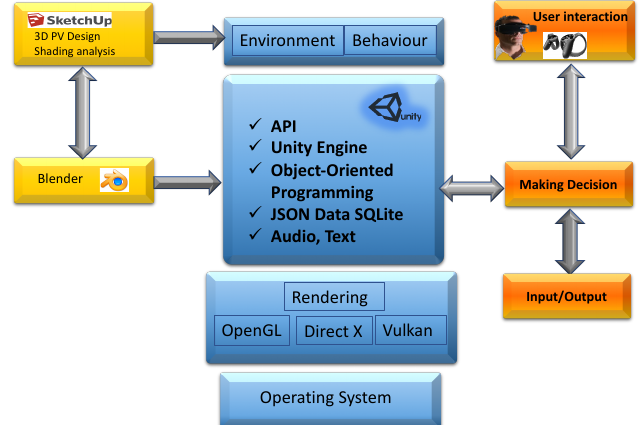
Figure 1. Proposed methodology for planning photovoltaic power plant (PV) in virtual reality (VR).